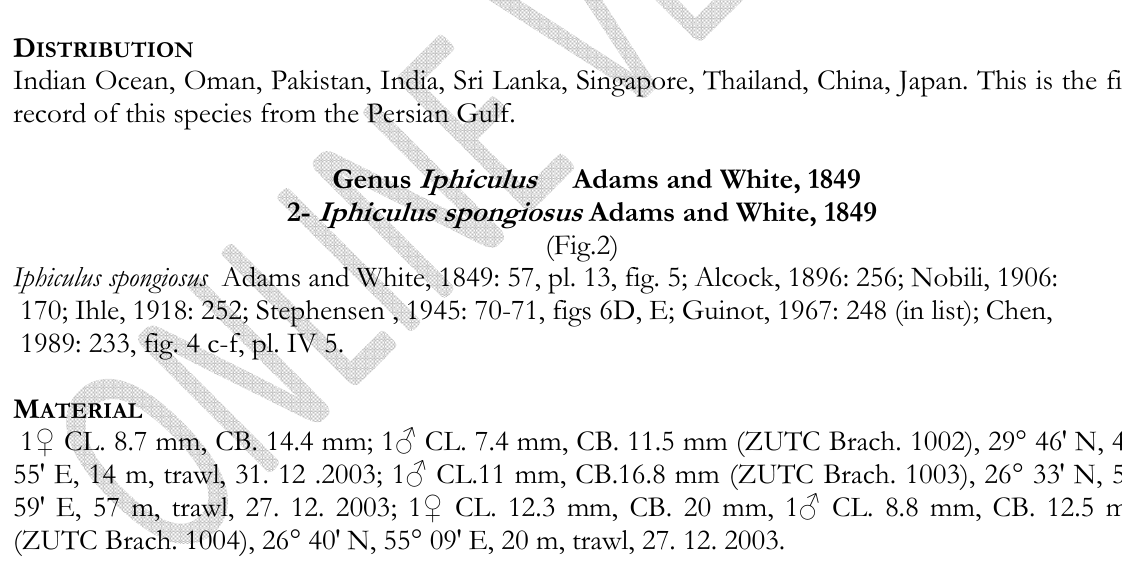
2._ Iphiculus spongiosus Adams & White, 1848: a, cheliped; b, F IG . first gonopod. Scale: 1